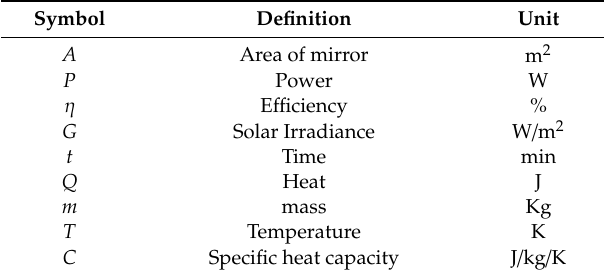
Table 1. Symbol, definitions and units for Equations